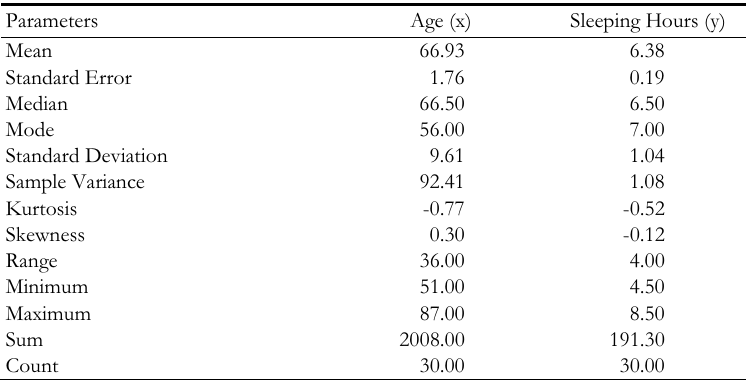
Summary of parameters of the population of N=30